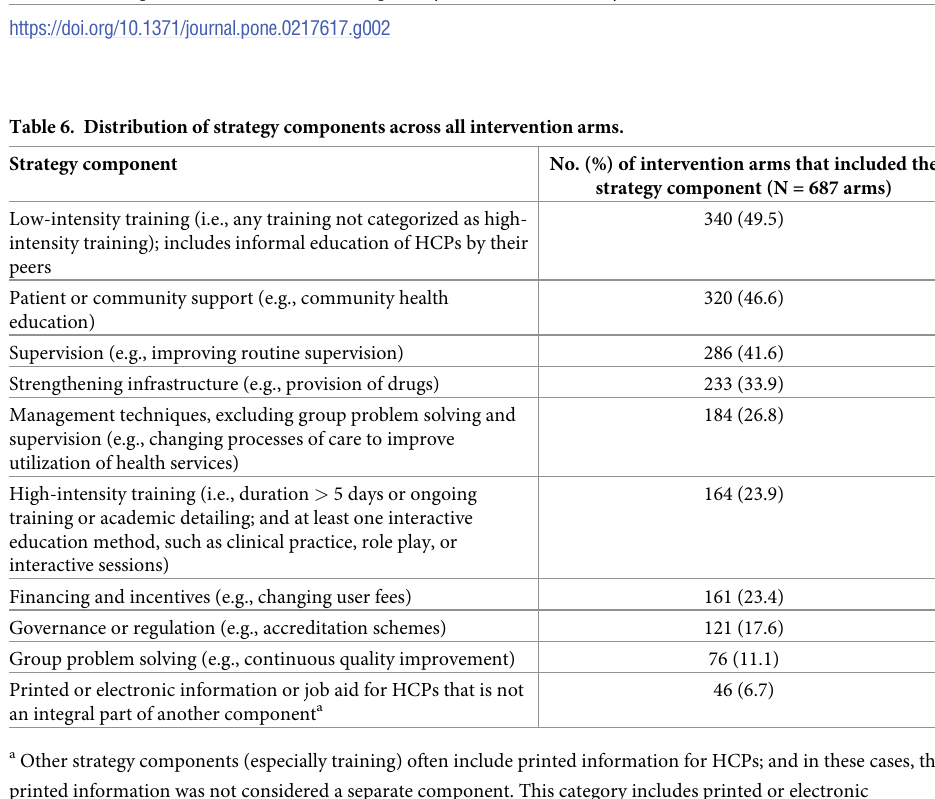
https://doi.org/10.1371/journal.pone.0217617.g002